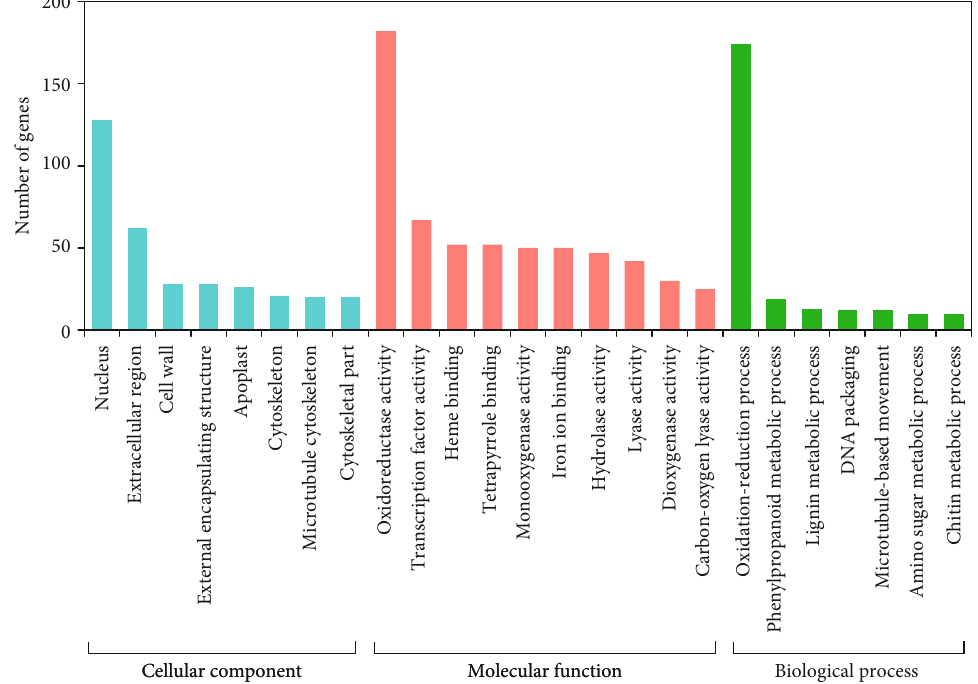
Figure 2: Gene ontology (GO) classi fi cations of DEGs. The DEGs are classi fi ed into three main categories: biological processes, cellular components, and molecular functions. The X -axis indicates the categories, and the Y -axis represents the number of DEGs in a category.